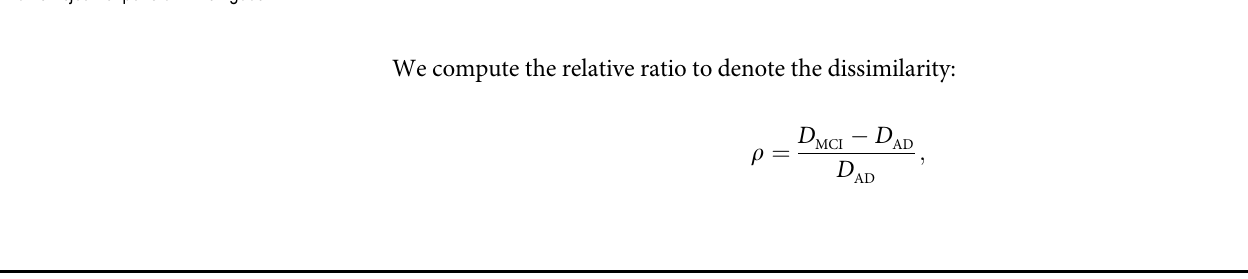
PLOS ONE | DOI:10.1371/journal.pone.0122731 April 28,